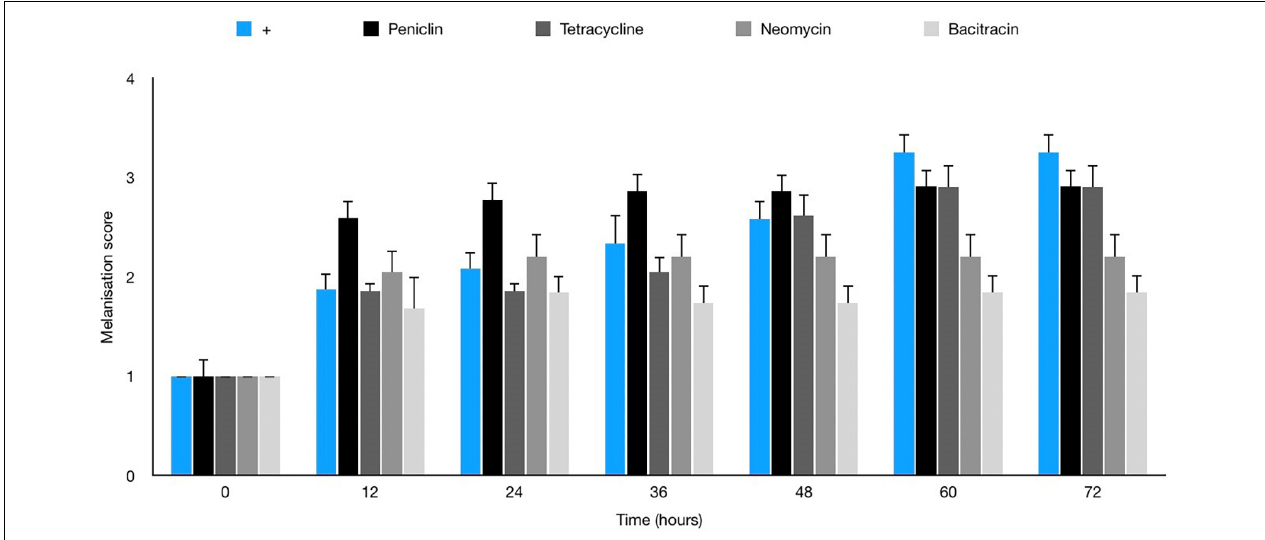
FIGURE 8 | Average melanisation score for larvae infected with 10 µ L of 10 7 JBCNJ055 with a further injection of either penicillin G (2 mg/kg), bacitracin (64 mg/kg), tetracycline (64 mg/kg), or neomycin (2400 mg/kg). Healthy larvae with no signs of infection were scored 1. Larvae showing nodulation and lateral line melanisation scored 2. Larvae exhibiting systemic melanisation scored 3. Dead, fully pigmented larvae scored 4. There is a potent increase in melanisation score when penicillin G is used in response to the infection.